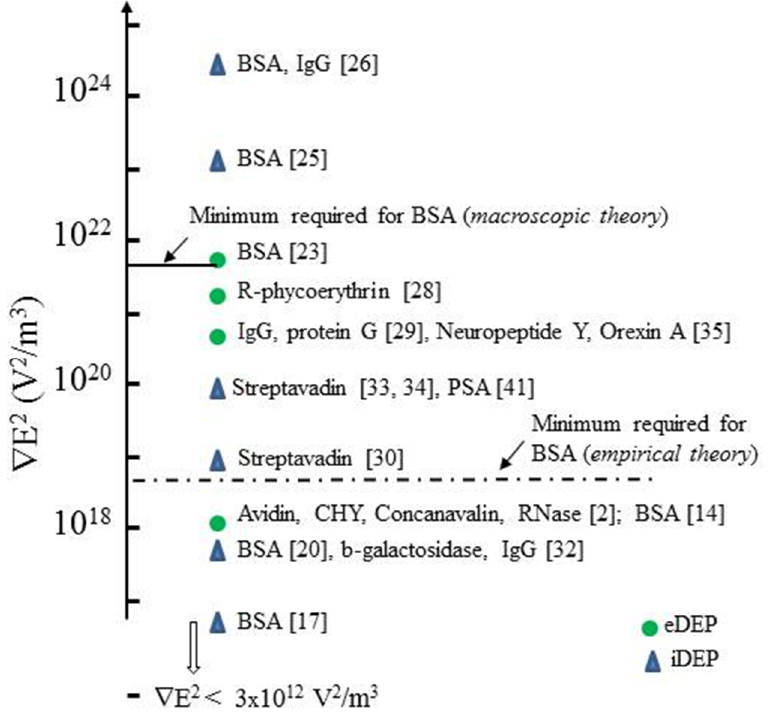
Figure 7. Values of the field gradient factor ∇ E 2 m as reported by the investigators or estimated by Hayes [5]. The minimum value of ∇ E 2 m required to compete against Brownian di ff usive e ff ects, calculated according to Equation (9), is shown for the case of BSA. The adjusted value shown for this is based on the empirical relationship described in Section 3.4.